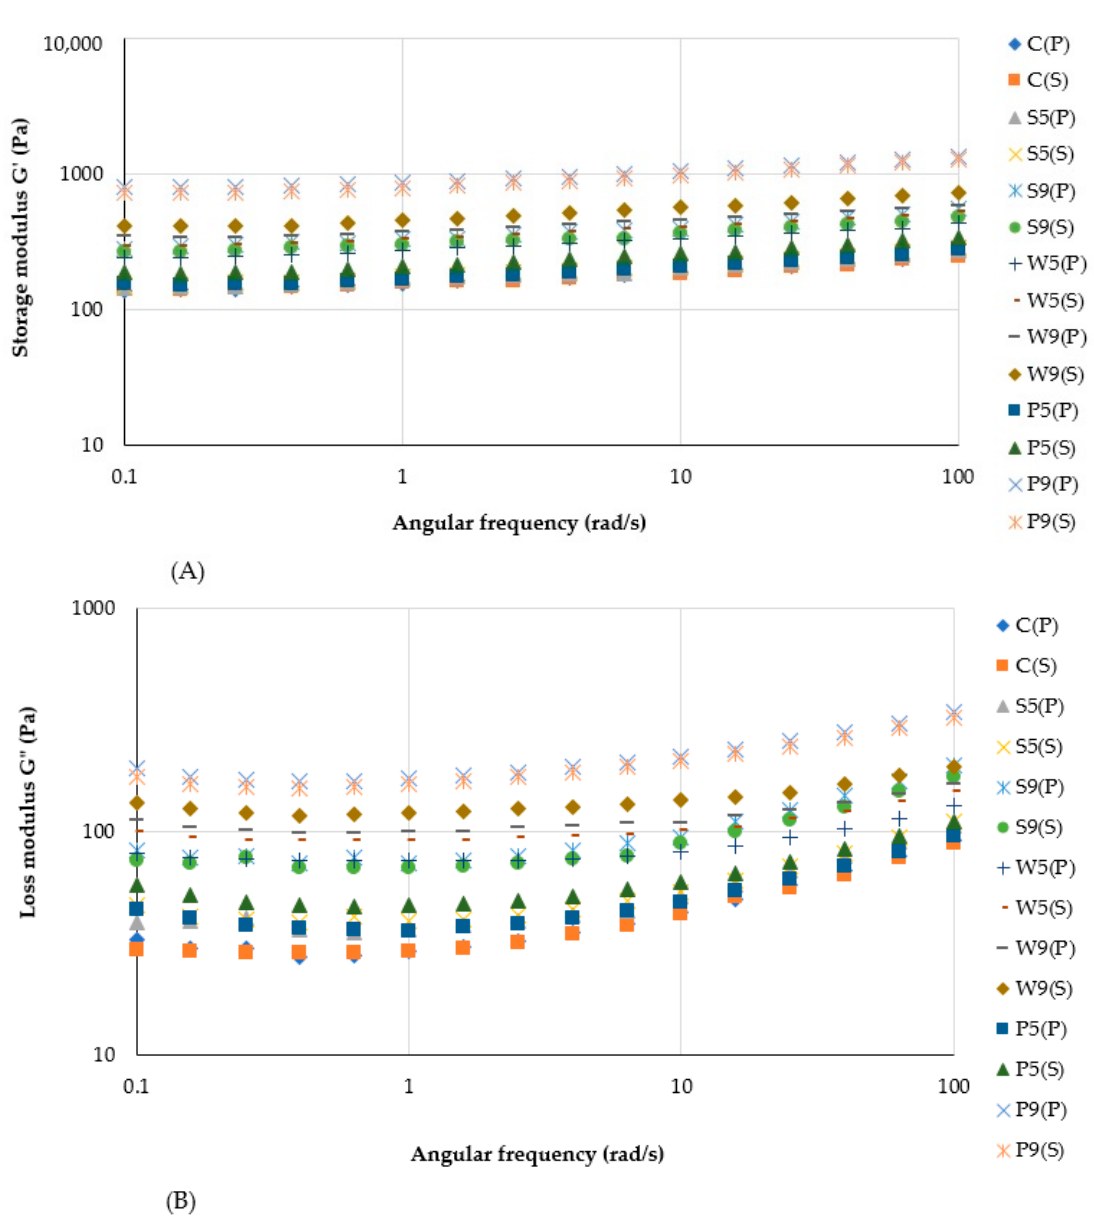
Figure 6. Storage ( A ) and loss ( B ) moduli for plant-based purées. The initial letters in sample abbreviations, C—control (without protein additive), S—soy, W—whey or P—pea protein, represent the samples used in the formulation; the number represents the proportion of protein added (5 or 9 g/100 g); the letters in brackets represent the type of secondary treatment (P—pasteurization; S— sterilization).